Question: Summarize what this figure shows in one sentence.
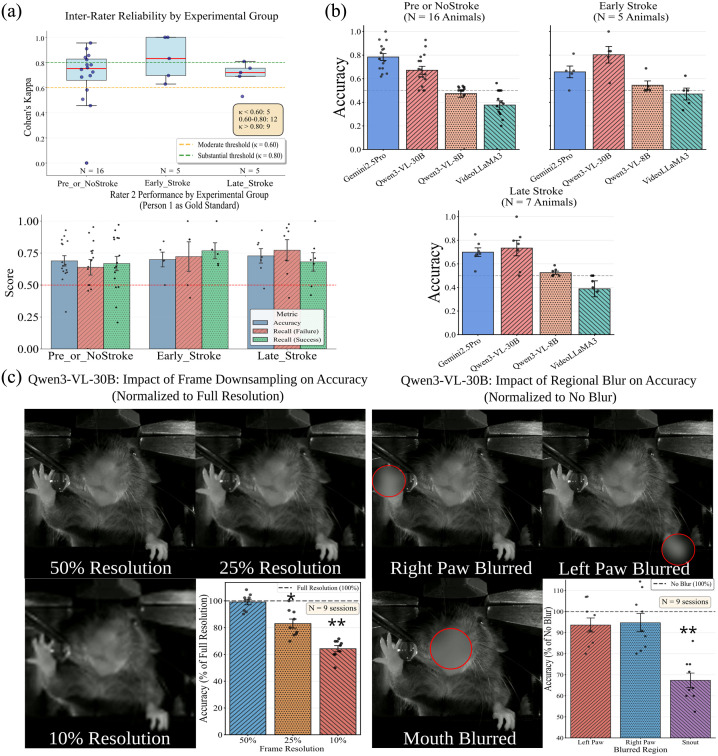
Answer: Model performance on water-reaching task. (a) Inter-rater reliability, as measured by Cohen’s kappa, between two expert human scorers across different experimental groups: Pre-or-no-stroke, early stroke, and late stroke. The dashed lines indicate moderate ( κ = 0.60 ) and substantial ( κ = 0.80 ) agreement thresholds and number of sessions that passed the corresponding threshold. (b) Accuracy of each tested model in classifying water-reaching trials across experimental groups. Data are calculated per session ( N ), which consists of multiple trial videos. (c) The effect of video resolution and part specific blurring on model performance. The left panel shows example frames at 50%, 25%, and 10% of the original resolution. The bar chart on the right shows the corresponding drop in classification accuracy compared with the original, un-blurred video (green dashed line). Each point represents a session of 6 to 88 trials; the ground truth is expert hand-scored results. Data are mean ± SEM. (b) Comparison of Gemini and human accuracy after corrections. Data are mean ± std. (c) The blurred region is enclosed by a red circle. * p < 0.05 , ** p < 0.01 , and *** p < 0.001 . Each point represents a session composed of 6 to 88 trials.